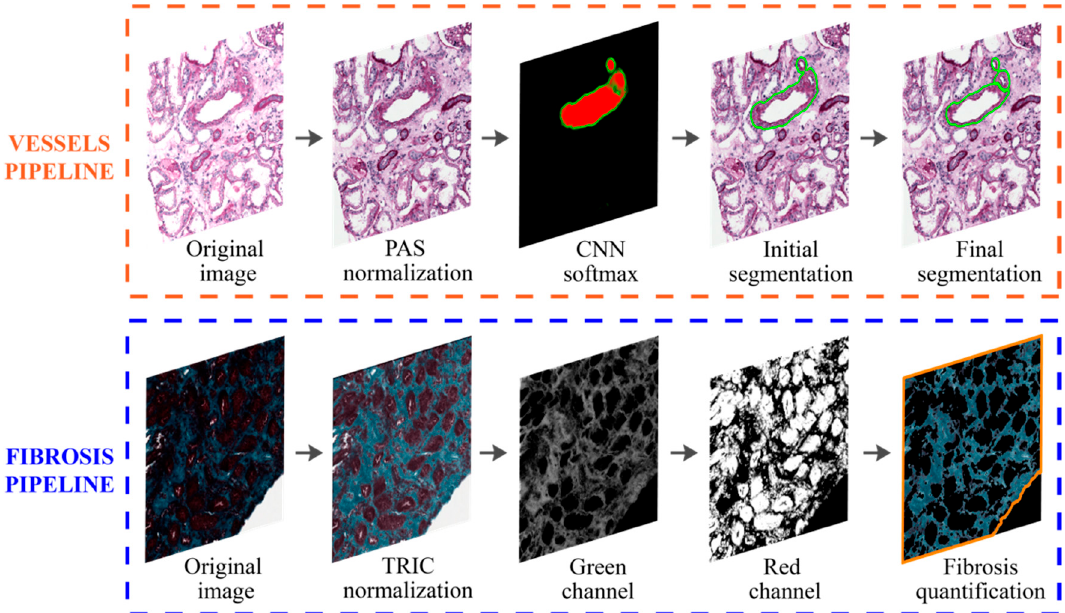
Figure 2. Flowchart of the RENFAST (Rapid EvaluatioN of Fibrosis And vesselS Thickness) algorithm for vessel and fibrosis segmentation. The first row illustrates the pipeline for blood vessel detection, while the second row shows the workflow of fibrosis segmentation. After PAS (periodic acid–Schiff) color normalization, blood vessels are detected using a deep learning method (CNN) and ad hoc post-processing. Kidney fibrosis is segmented through TRIC (Massone’s trichrome) normalization followed by adaptive stain separation.